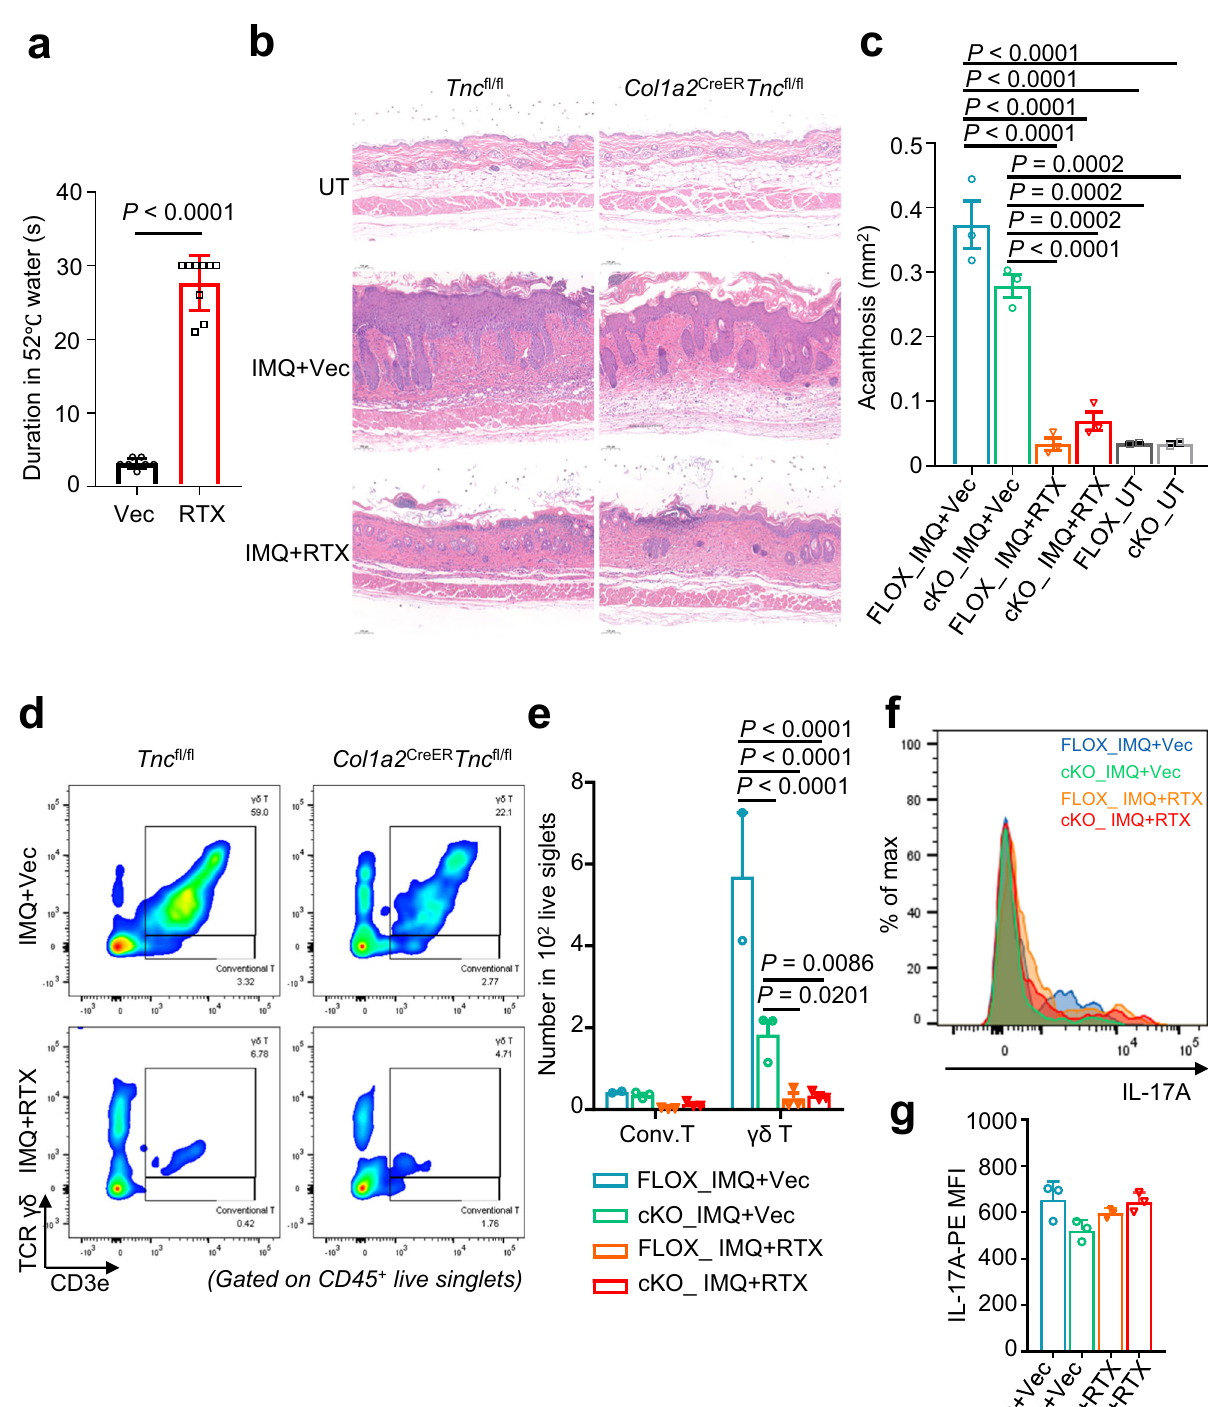
Fig. 6 | Cutaneous nociceptors serve as essential downstream of TNC in med- iating skin in fl ammation. a Quanti fi cation of tail fl ick time in 52°C hot water of vehicle(Vec, n =7)orresiniferatoxin(RTX, n =9)-treated Tnc fl / fl and Col1a2 CreER Tnc fl / fl mice. Representative H&E staining images ( b ) and quanti fi cation ( c ) of skin acan- thosis of untreated (UT)/IMQ-induced Tnc fl / fl or Col1a2 CreER Tnc fl / fl mice treated with VecorRTX( n =2 – 3pergroup).FLOX, Tnc fl / fl ;cKO, Col1a2 CreER Tnc fl / fl .Scalebarin( b ), 100 μ m. Flow cytometric analysis ( d ) and quanti fi cation ( e ) of conventional T-cell and γδ T cellsin skinlesions of IMQ-induced Tnc fl / fl or Col1a2 CreER Tnc fl / fl mice treated